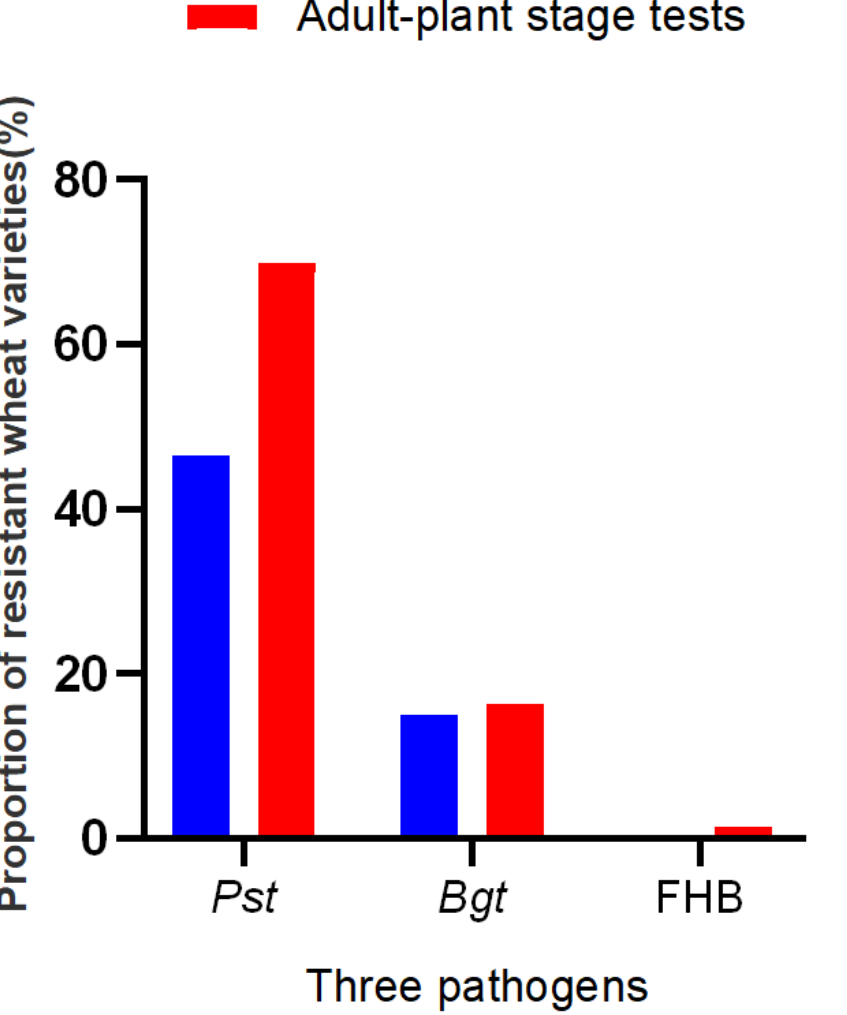
Figure 1. The proportion of wheat entries with different types of resistance to stripe rust, powdery mildew, and FHB.